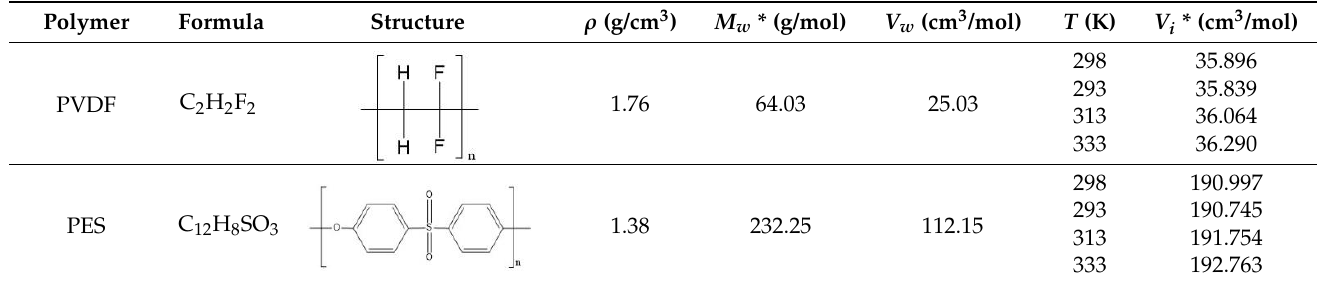
Table 3 compiles the chemical structure and parameters relevant for the mathematical model of the monomer unit of the polymers. Table 3. Chemical structure and properties of monomer units of the polymers.